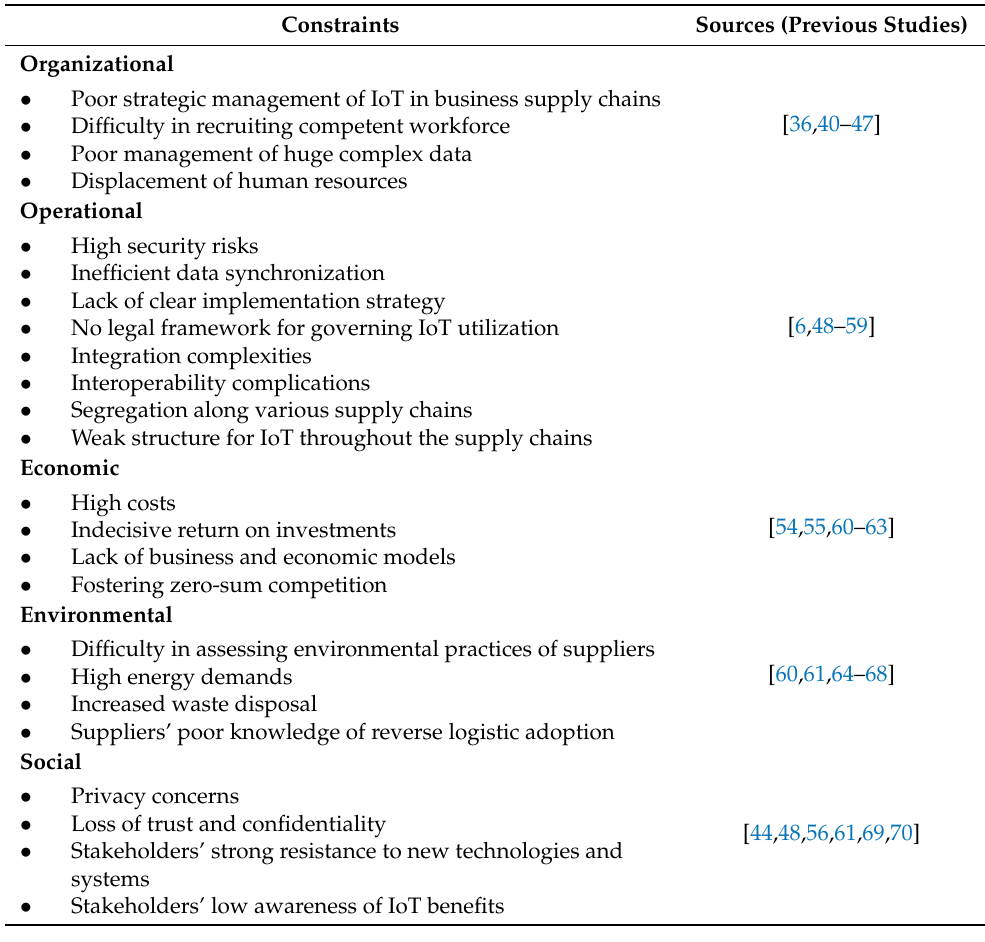
Table 1. List of the IoT utilization constraints extracted from the related literature. Constraints Sources (Previous